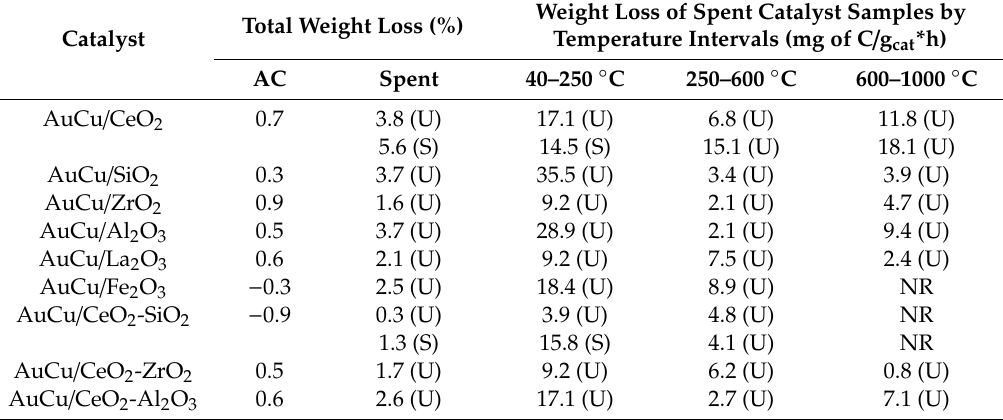
Table 3. Weight loss of Au–Cu catalysts supported on single and dual supports evaluated in CO removal from an actual